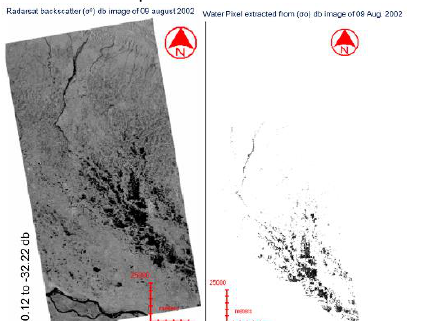
Fig. 3.4: Rdarsat-1 backscatter image with extracted water map.